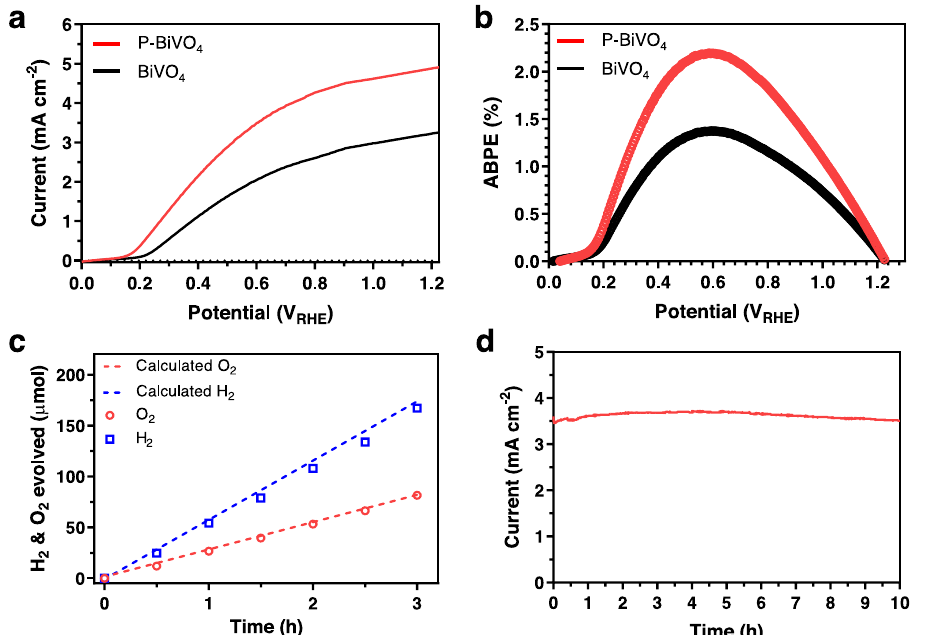
c Gases evolved from the phosphorus doped BiVO 4 samples at 0.6 V RHE under back illumination for 3h and the calculated amounts of gas assuming 100% Faradaic ef fi ciency (dashed line). d Chronoamperometry curve of the phosphorus-doped BiVO 4 sample with co-catalyst of NiFeO x measured at 0.6 V RHE under AM1.5G simulated